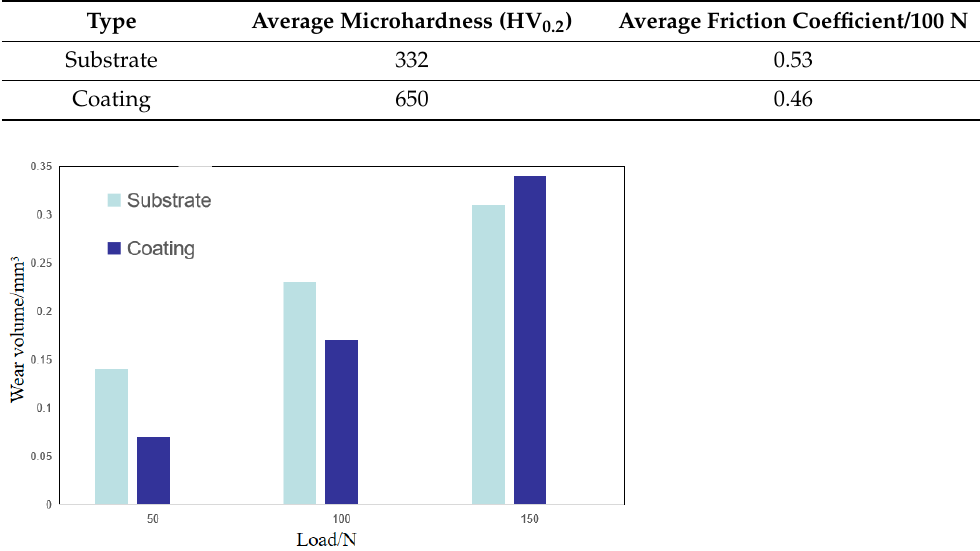
Figure 11. The wearing amounts of titanium alloy substrate and cladding layer under different loads.